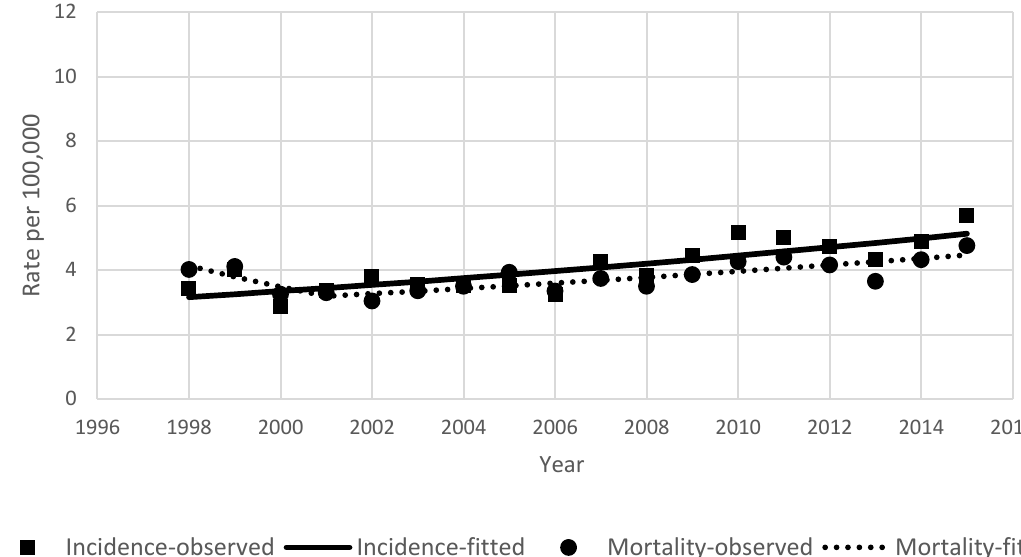
Figure 1. Primary liver cancer in Lithuania between 1998 and 2015. Age-standardized incidence and mortality rates in both sexes.